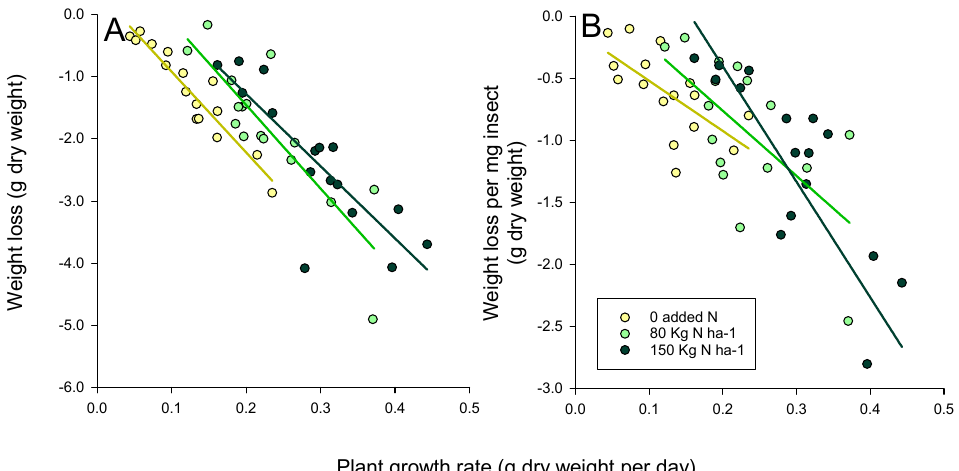
Figure 1. ( A ) FPLI for 16 varieties/lines at three nitrogen levels, with ( B ) changes in plant growth